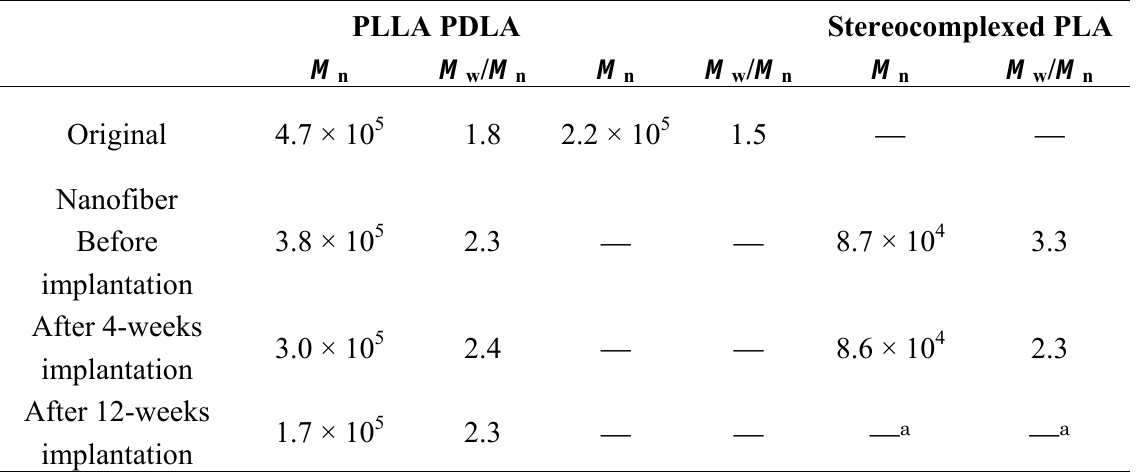
Table 3. Molecular weight of PLA nanofibers before and after 4-week and 12-week implantation in vivo